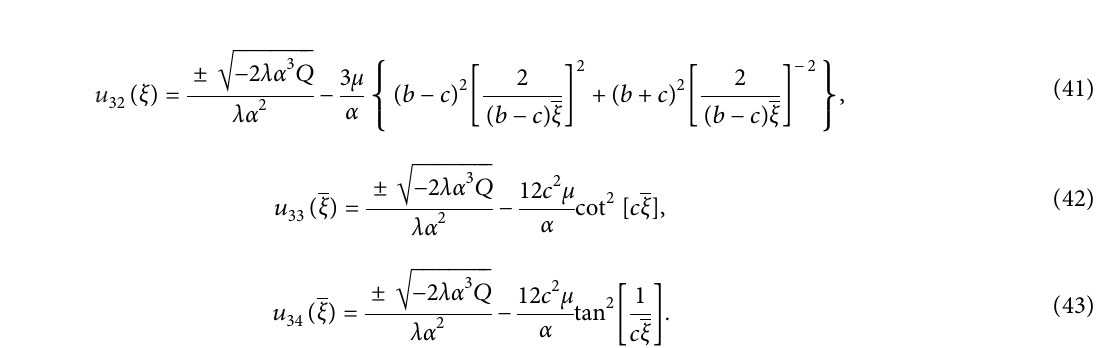
1: Te three-dimensional fgure and the plane fgure of